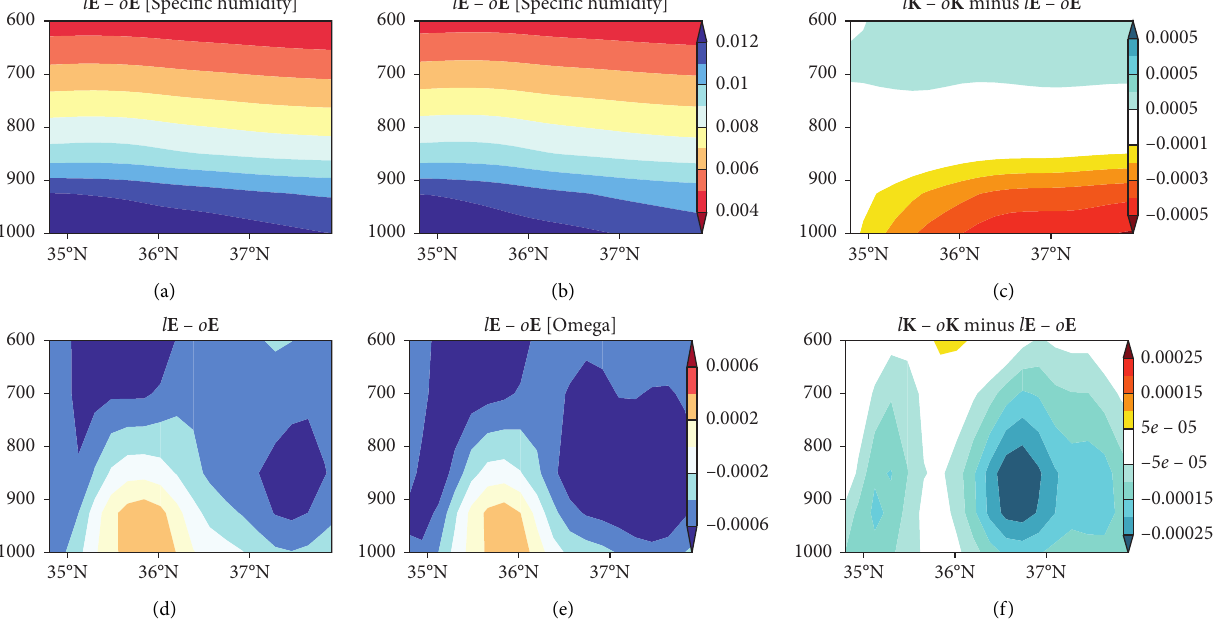
Figure 12: Vertical-latitudinal structure of (a), (b) climatological specific humidity (kg/kg) and (d), (e) omega (hPa/s) along the latitudes at 127.6 ° E, and (c), (f) their differences derived from (a, d) l E − o E and (b, e) l K − o K